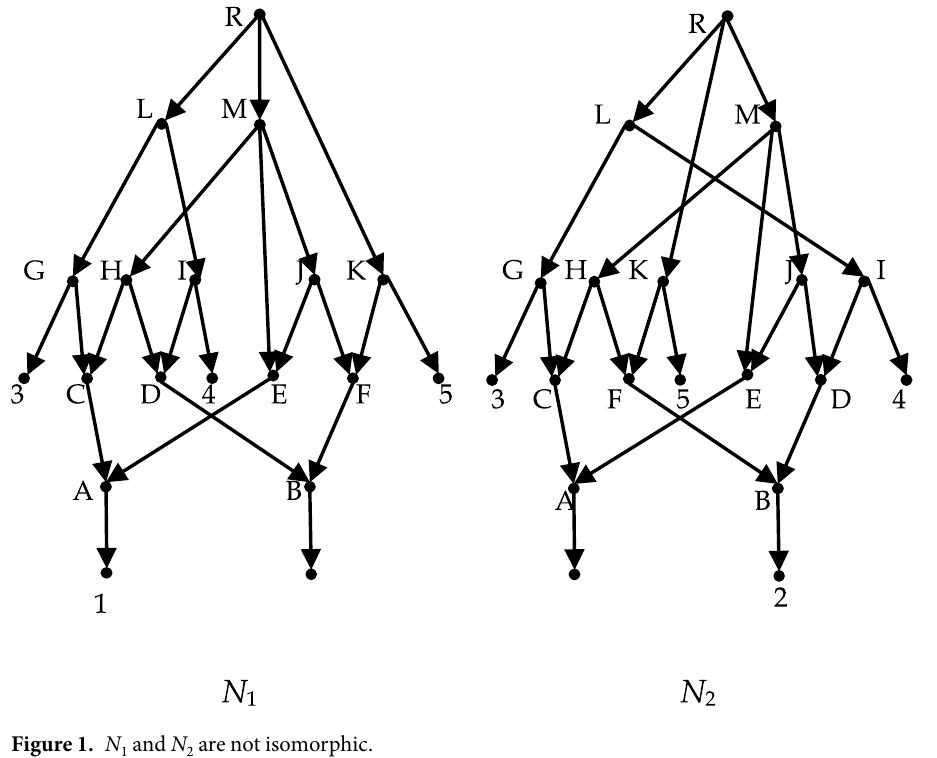
Figure 1. N 1 and N 2 are not